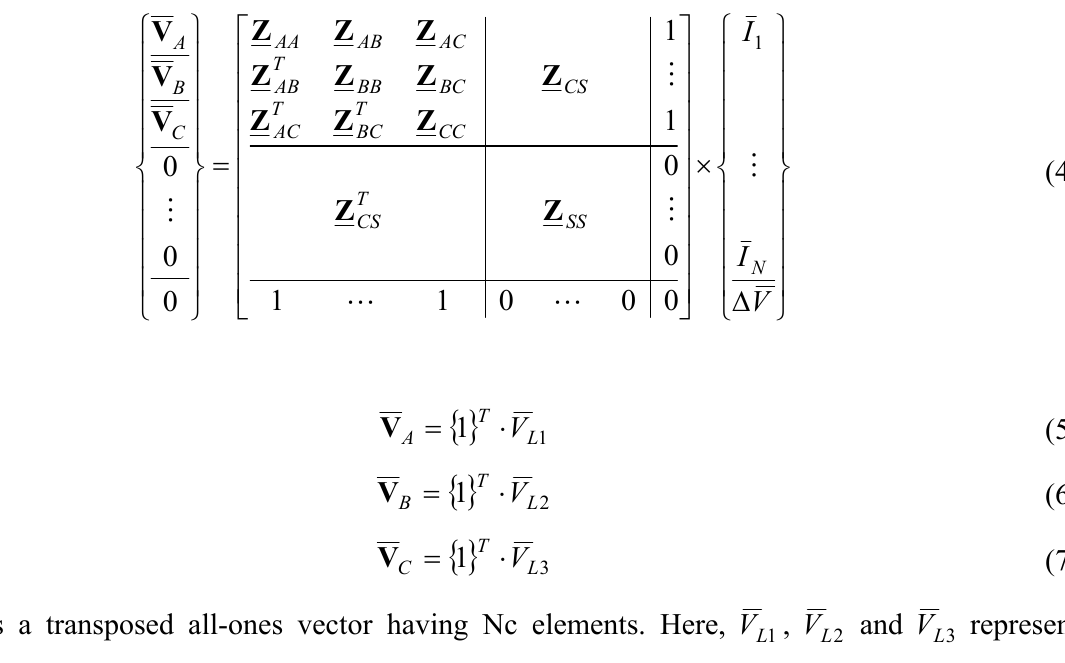
—square submatrices each with dimension (Nc, Nc) of